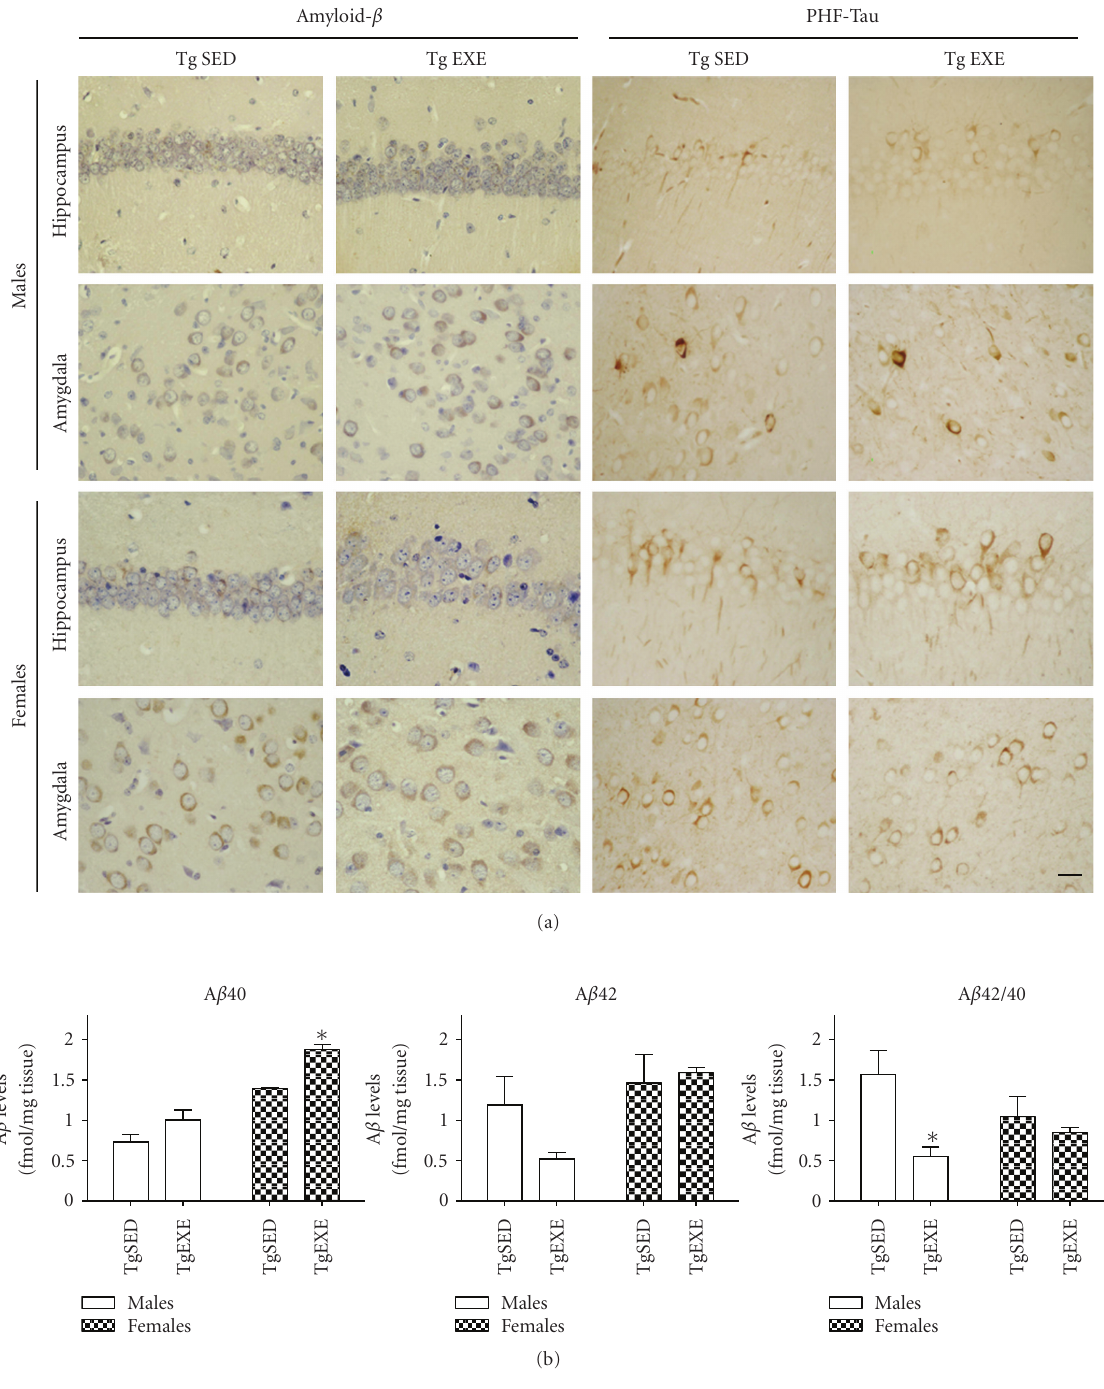
Figure 3: Brain pathology in male and female 3xTg-AD sedentary mice (TgEXE) is partially protected against by treadmill running exercise (TgSED). (a) Representative microphotographs of hippocampus CA1 and basolateral amygdala showing amyloid- β and PHF- tau immunoreactivity using antibodies 4G8 and AT180, respectively. 4G8 reacts against amino acids 1–17 of amyloid β . AT180 detects phosphorylated tau at the threonine 321 residue. No changes in intraneuronal amyloid β or PHF-tau were induced by exercise. Scale bar = 20 μ m. (b) Levels of soluble amyloid β 40 (A β 40) and amyloid- β 42 (A β 42) in cerebral cortex as determined by sandwich ELISA. Treadmill exercise induced a protective change by decreasing the A β 42/A β 40 ratio (A β 42/40) (ANOVA, P = . 0110). Values are the mean ± SEM, n = 3-4. Statistics: ∗ P < .